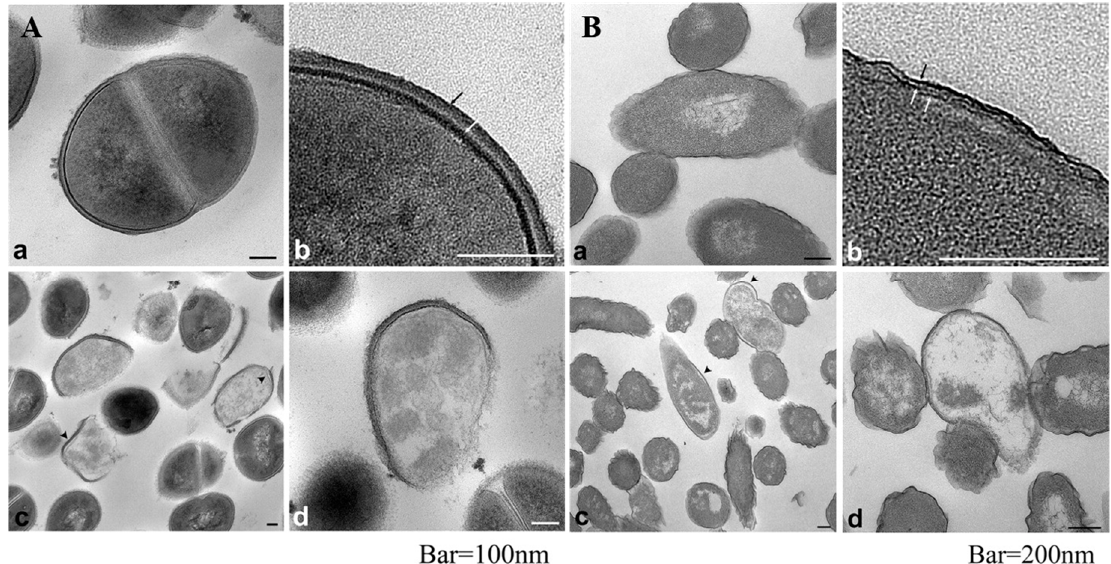
Figure 1. Internal morphology of S. aureus ( A ) and E. coli ( B ) observed via TEM ( a , b ) untreated bacteria, ( c , d ) bacteria treated with Ag + (0.2 ppm) during 2 h. Black and white arrows indicate peptidoglycan and cytoplasmic membrane, respectively ( A ) and outer membrane, peptidoglycan and cytoplasmic membrane ( B ). Arrowhead indicate separation of the cell membrane from the cell wall. Reprinted from [40] with American Society for Microbiology Publishing Group permission.